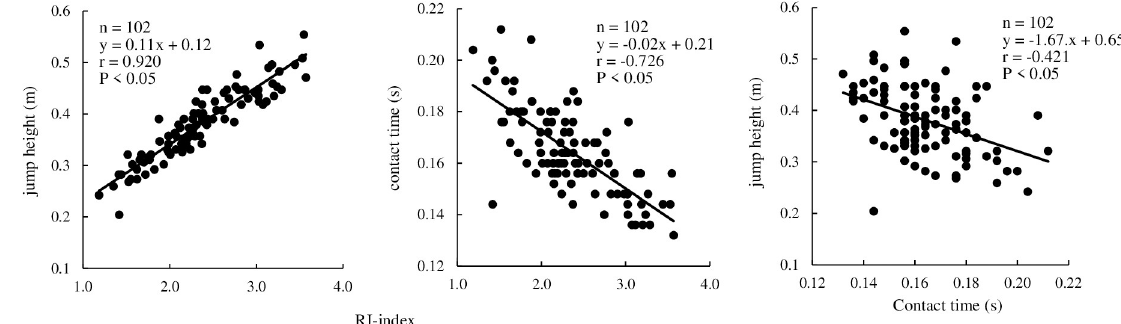
Fig 3. Relationship among performance variables in the rebound jump